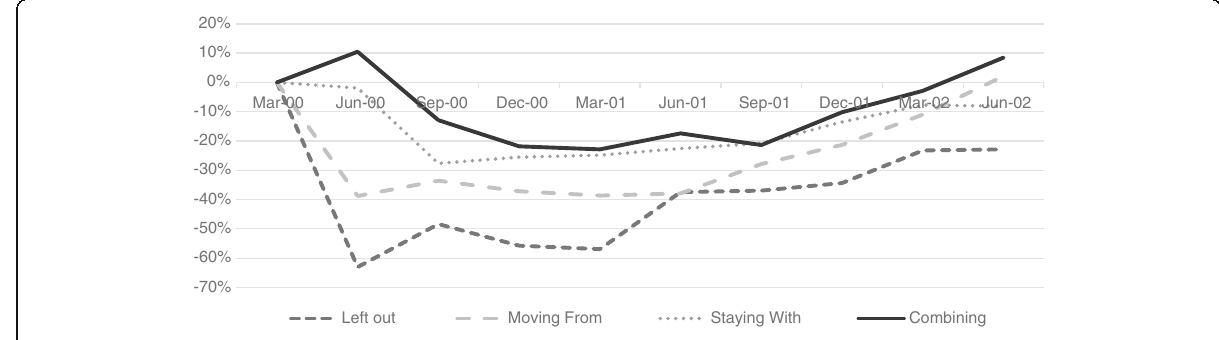
Figure 4 Herd size over time, % change on March 2000 (Mar-00) to June 2002